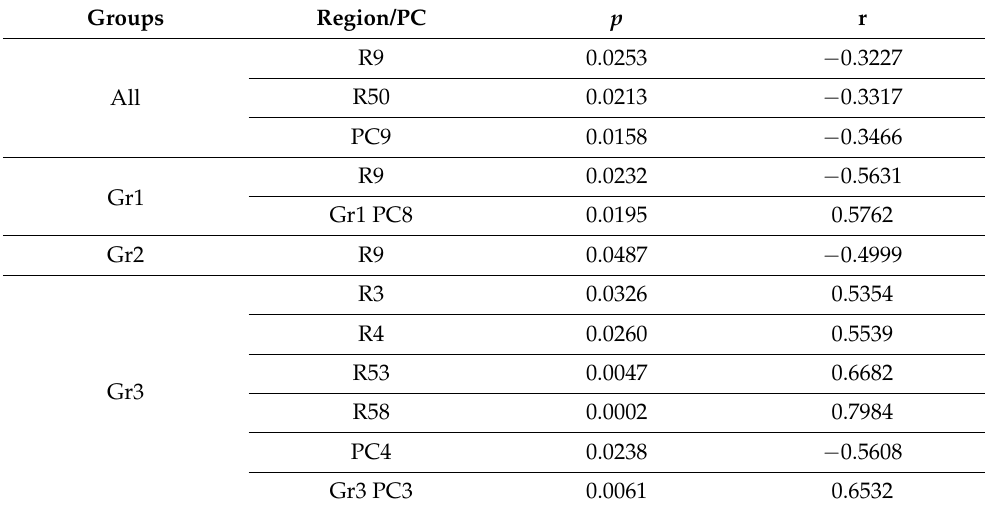
R4 0.0260 0.5539 R53 0.0047 0.6682 R58 0.0002 0.7984 PC4 0.0238 Gr3 PC3